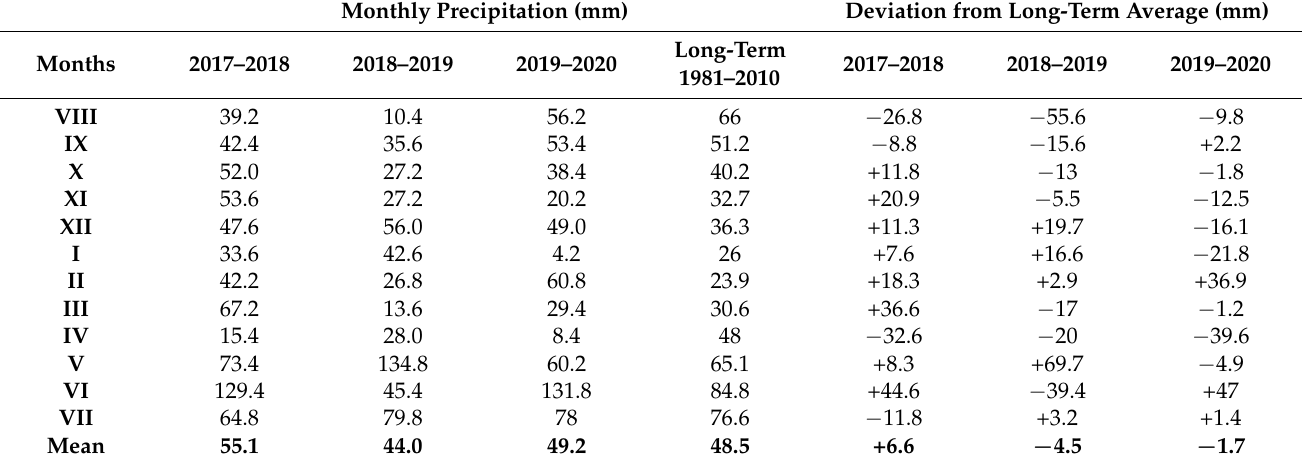
Table 2. Precipitation trends during the canola growing seasons (2017–2020) and comparison with the multiannual (1981–2010) mean values of the